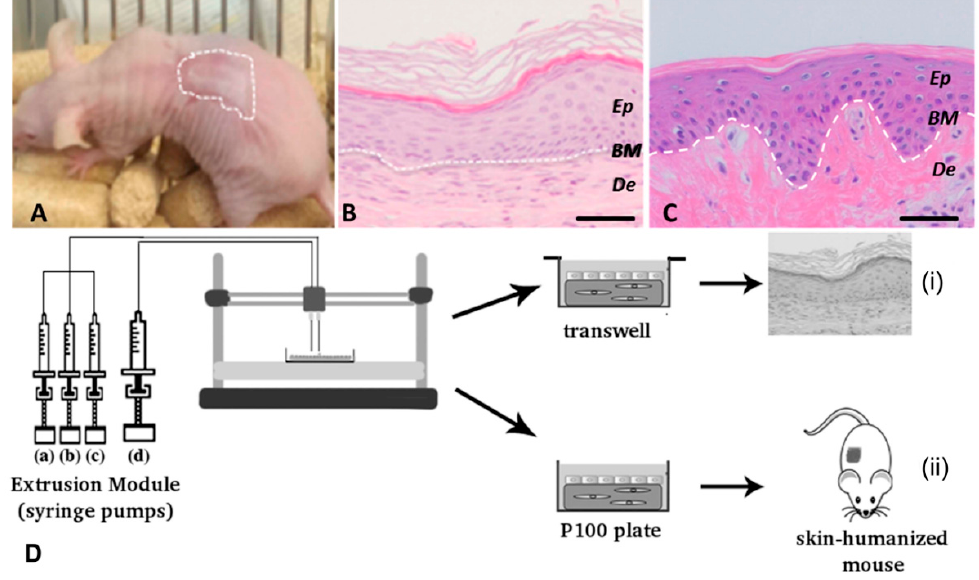
Figure 7. Cubo et al.’s 3D bioprinting of functional human skin: production and in vivo analysis. Histological analysis (8 weeks postgrafting) of bioprinted human skin grafted to immunodeficient mice. ( A ) Visual appearance of the grafted human skin. The dotted line marks the boundary between human and mouse skin. ( B ) H&E staining of the regenerated human skin. ( C ) H/E staining of normal human skin. The white dotted line in ( B , C ) indicates the dermo–epidermal junction (basal membrane, BM). Ep and De in ( B , C ) denote the epidermal and the dermal compartments, respectively. Scale bar: 100 µm. ( D ) Scheme of the bioprinting process. The extrusion module contained four syringes, loaded with human fibroblasts (hFBs) (a), plasma (b), CaCl 2 (c) and human keratinocytes (hKCs) (d), respectively. The contents of the syringes (a–c) were continuously pumped out at the appropriate speed, mixed as they arrived at the head, extruded through the needle and deposited on the corresponding plate type (P100 or transwell), following the trajectories dictated by the control unit. This mixture was allowed to polymerise for 30 min at 37 ◦ C to form a fibroblast-containing fibrin hydrogel, which became the dermal compartment of the skin equivalent. Immediately after this polymerisation step, the hKCs suspension contained in syringe (d) was similarly deposited on top of this hydrogel to form a confluent monolayer. (i) Equivalents printed on transwell inserts were allowed to differentiate at the air–liquid surface for 17 d and then analysed. (ii) Equivalents printed on P100 plates were grafted on to the backs of immunodeficient mice for eight weeks and then analysed. Reproduced with permission from Cubo et al. [129]. Copyright 2016